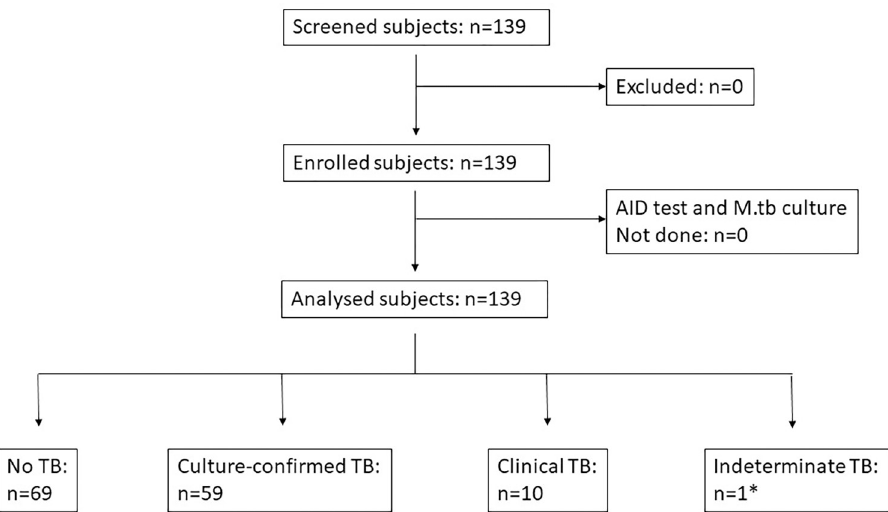
Fig 1. Study flow-chart. No TB: no growth of M . tuberculosis in any sputum sample and clinical recovery without anti-TB treatment; culture-confirmed TB: at least one M . tuberculosis positive culture result (either on LJ or VersaTEK liquid culture) for at least one out of two analyzed sputum samples, clinical TB: no microbiological proof of M .